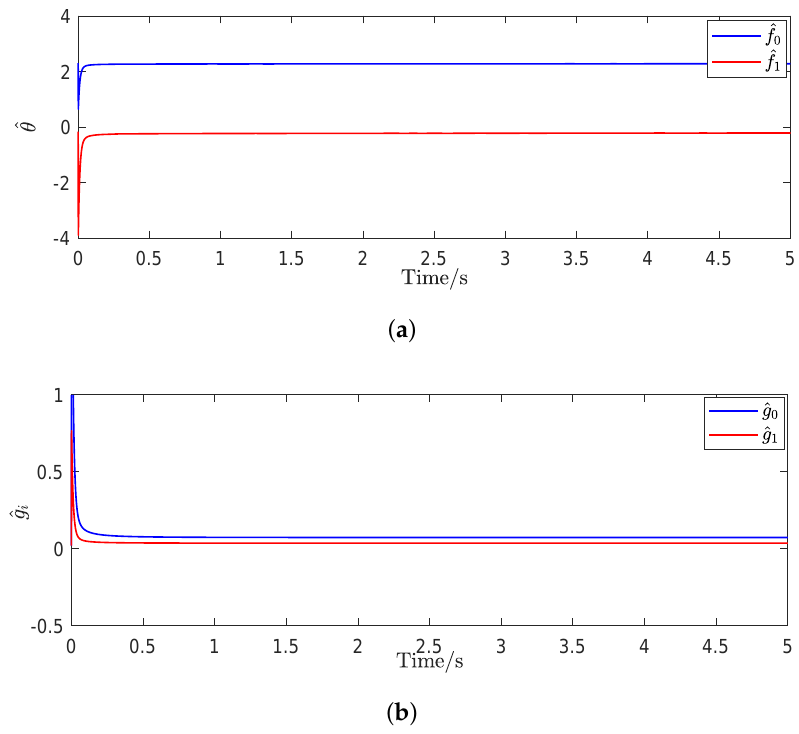
Figure 10. Estimates results of the parameters ˆ θ and ˆ g i . ( a ) convergent curve of ˆ θ ; ( b ) convergent curve of ˆ g i .